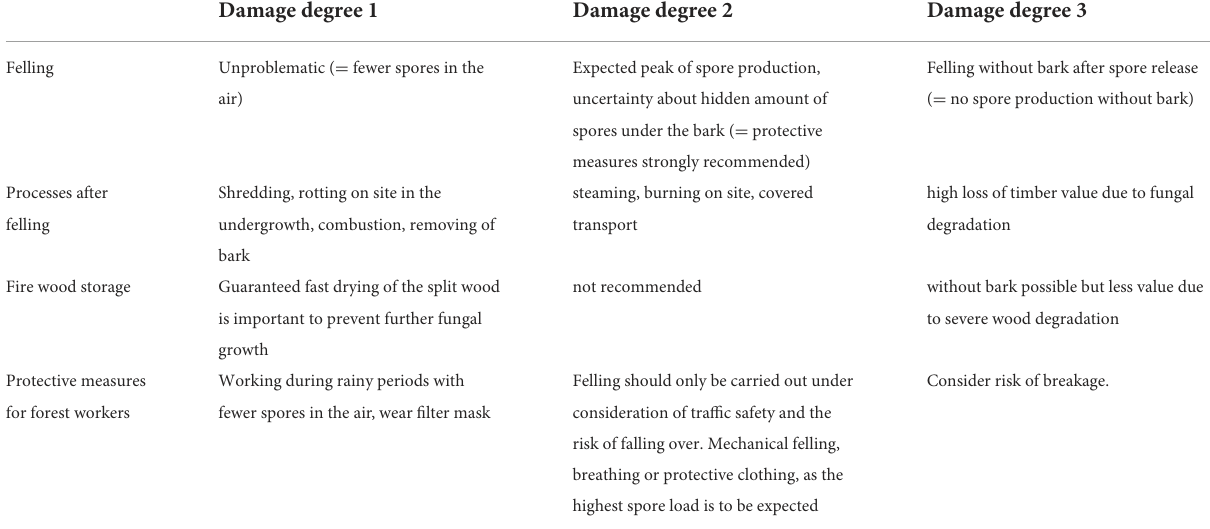
TABLE 4 General recommendations from operative